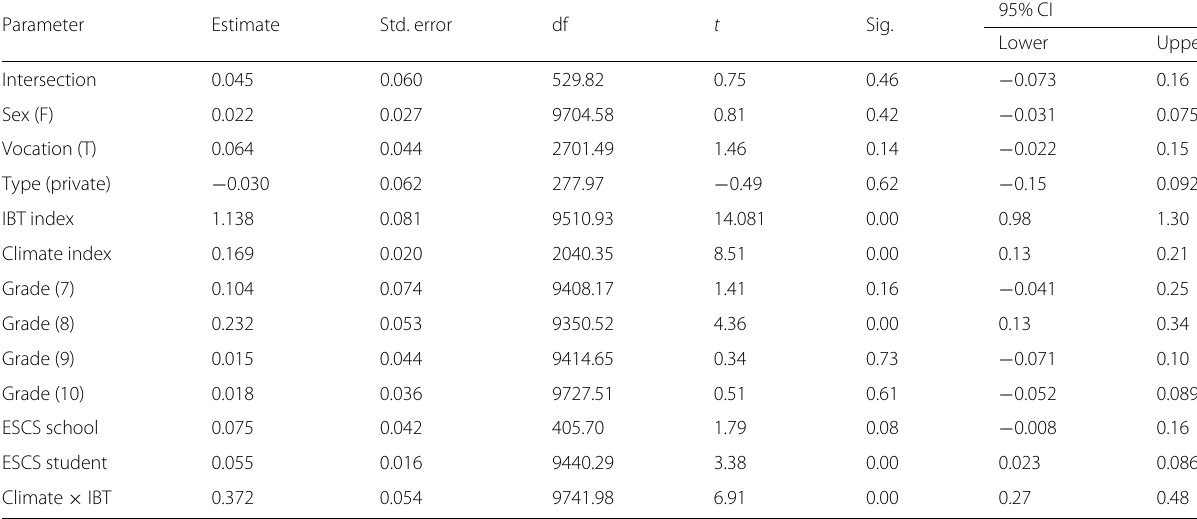
Table 4 Predictors associated with critical thinking